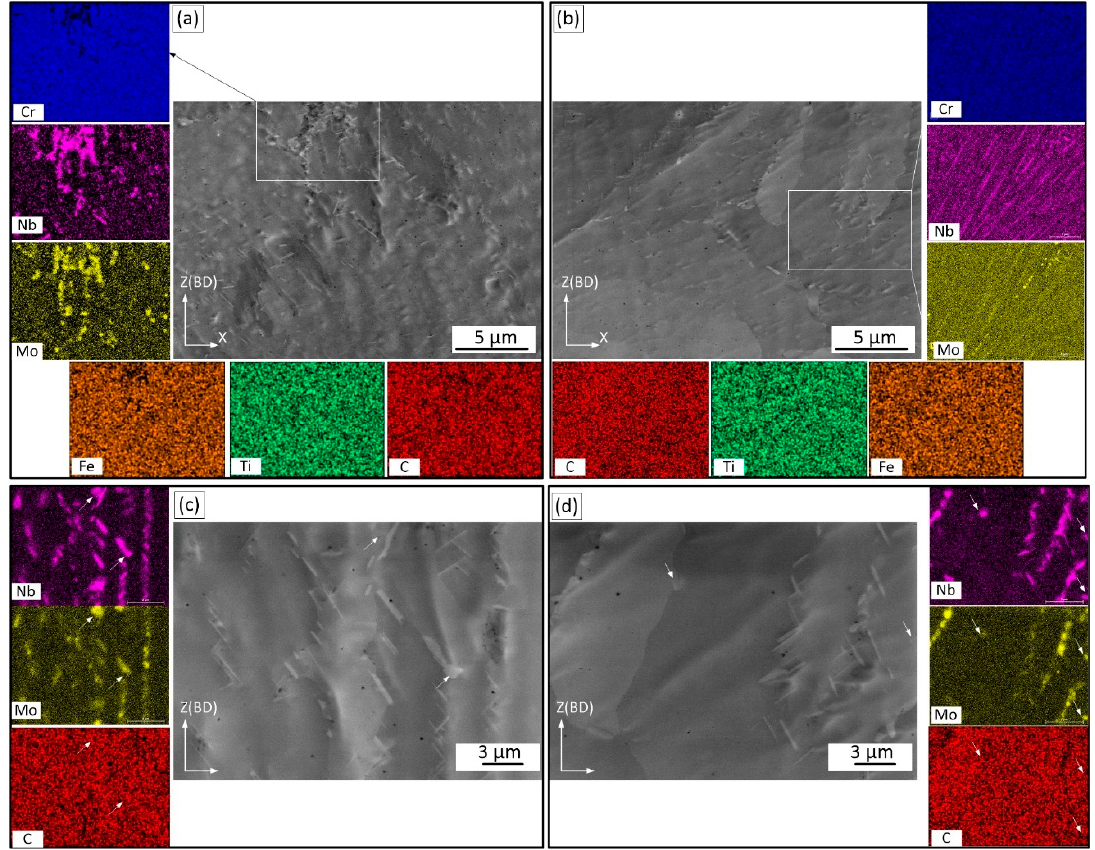
Figure 4. Precipitation after SR in ( a , c ) Alloy 1 and ( b , d ) Alloy 2 with their respective elemental maps.